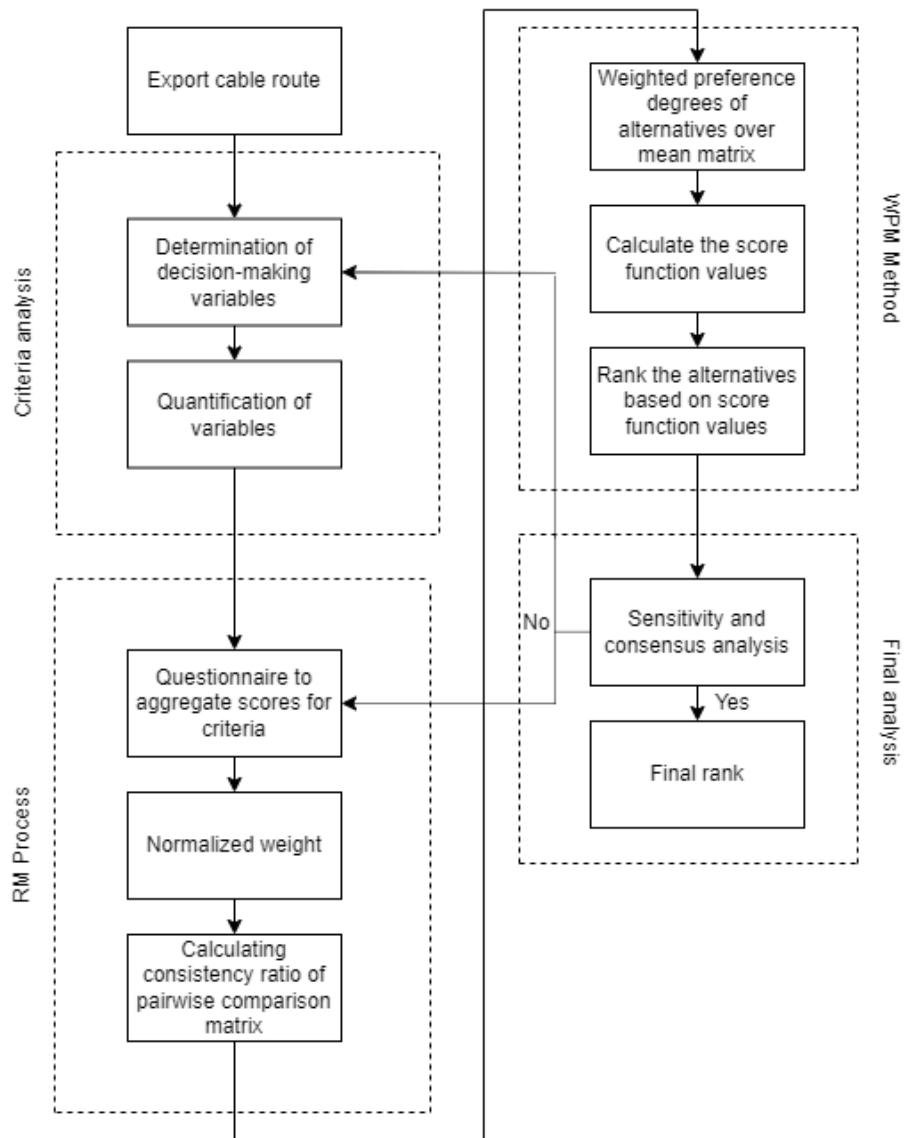
Figure 2. Flowchart with the methodology for designing the export cable route.